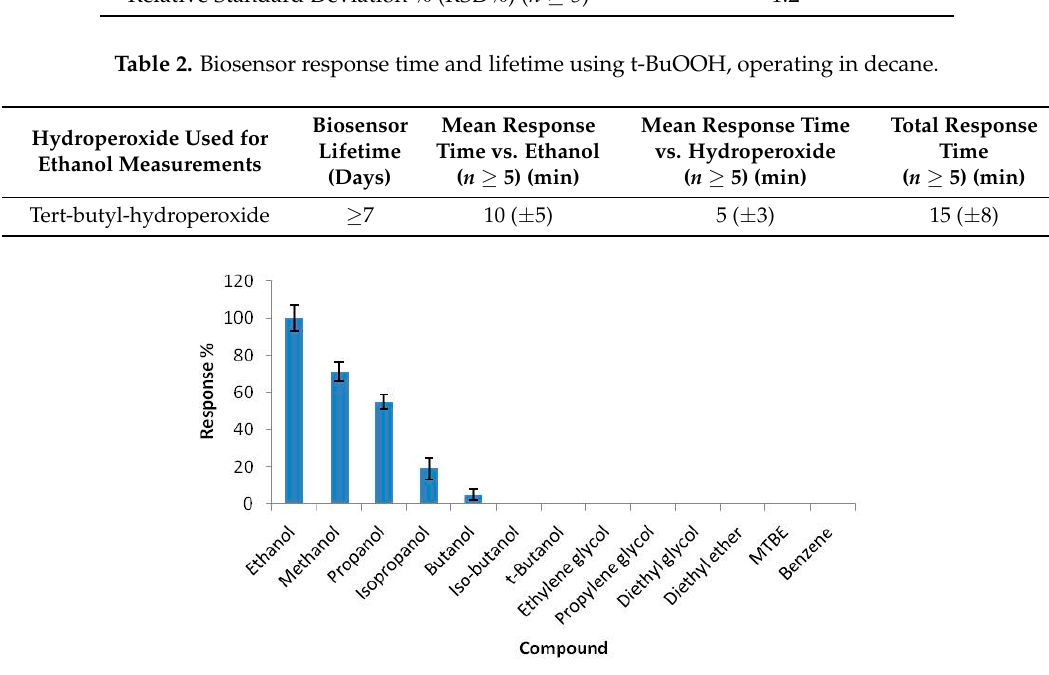
Figure 4. Selectivity of ethanol biosensor towards possible more-common alcohol interferents.